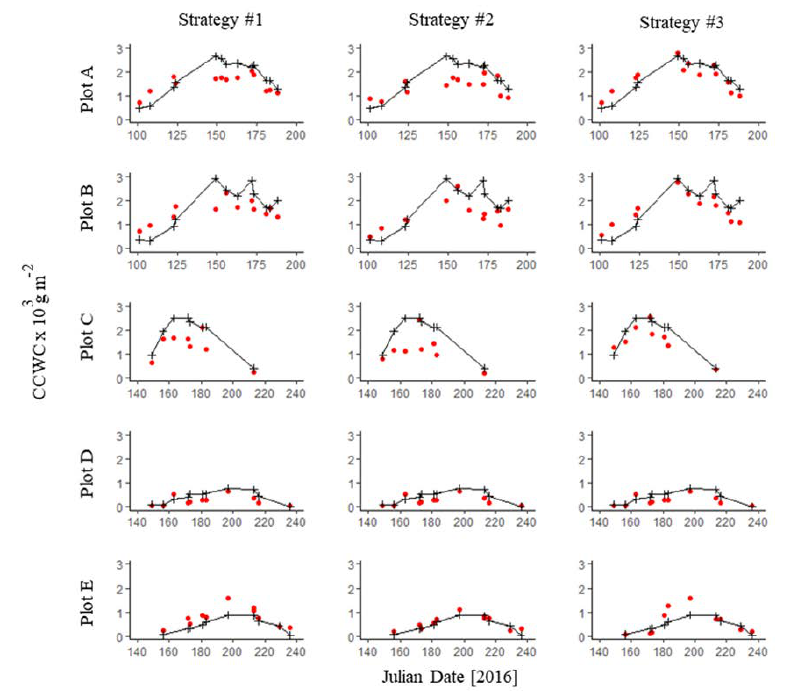
Figure 11. Time series of measured (black crosses) and estimated (red dots) CCWC for each inversion strategy (#1: left, #2: middle, and #3: right) during the 2016 growing season. Plots A and B were located in winter wheat fields. Plot C was located in a barley field. Plots D and E were located in from garbanzo fields.